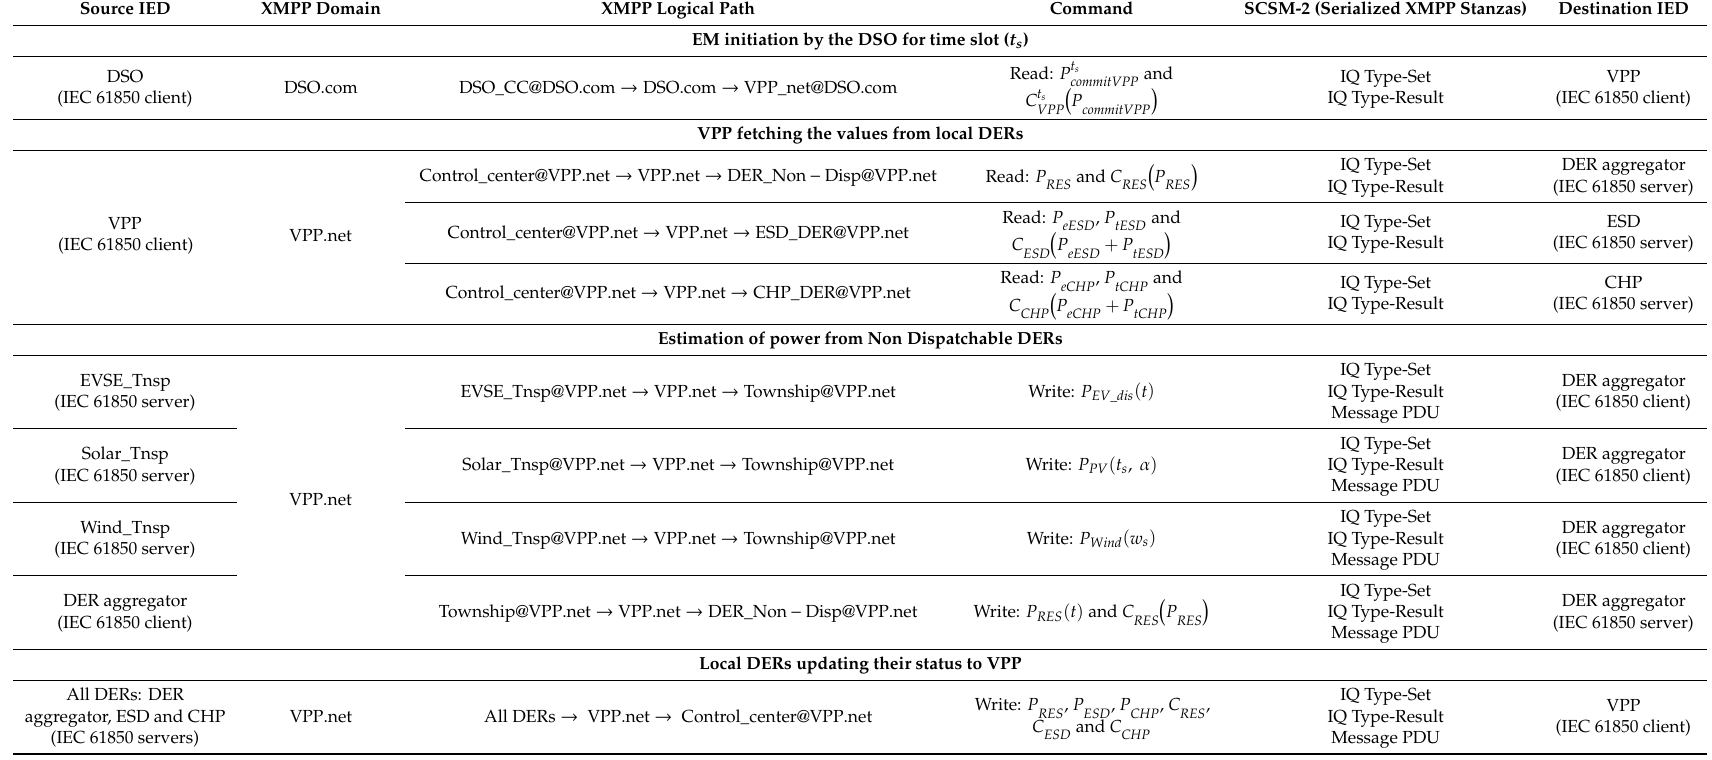
Table 1. Message exchanges inside VPP (single JID